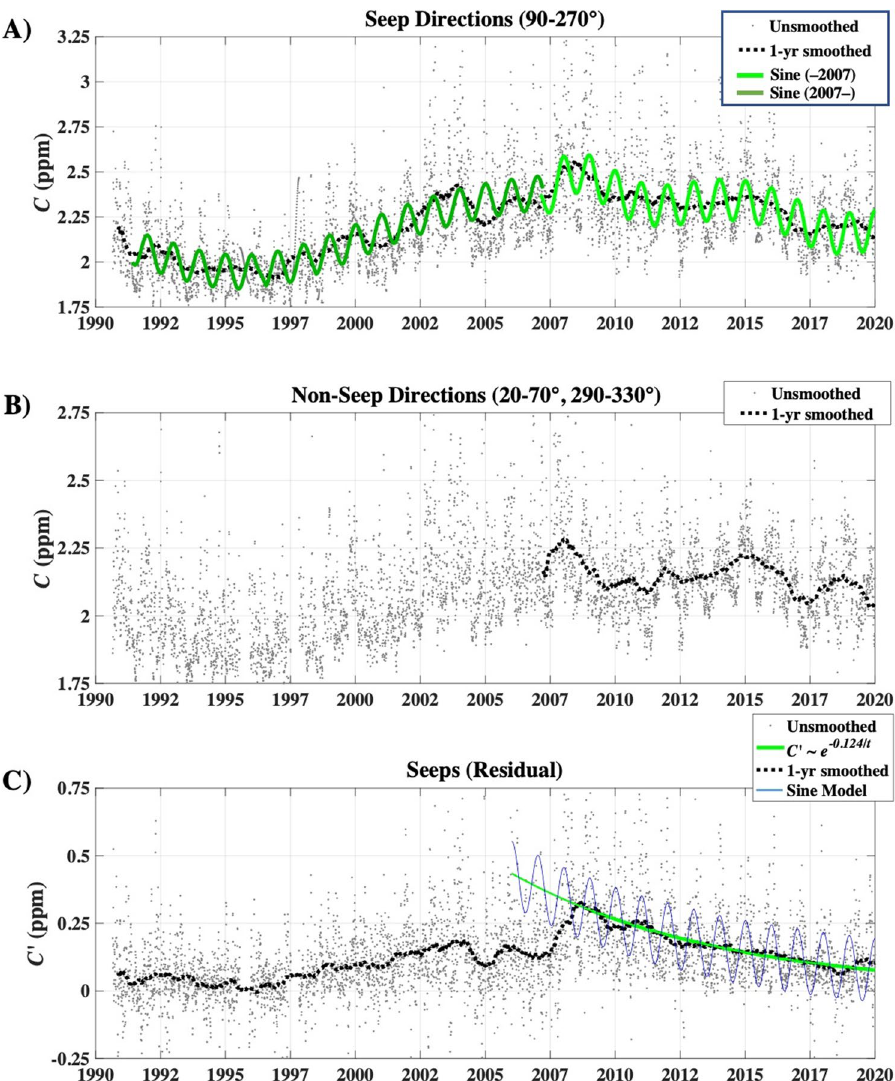
Figure 4. ( A ) Seep directions (90°–270°) and disjoint sinusoidal model with a shift at 2007, ( B ) channel background (260°–290°), ( C ) seep-background difference and exponential fit for 2008–2020. Data keys on panels. See supplementary Fig. S2 for C ′ (cid:31) t , θ seep (cid:30) for